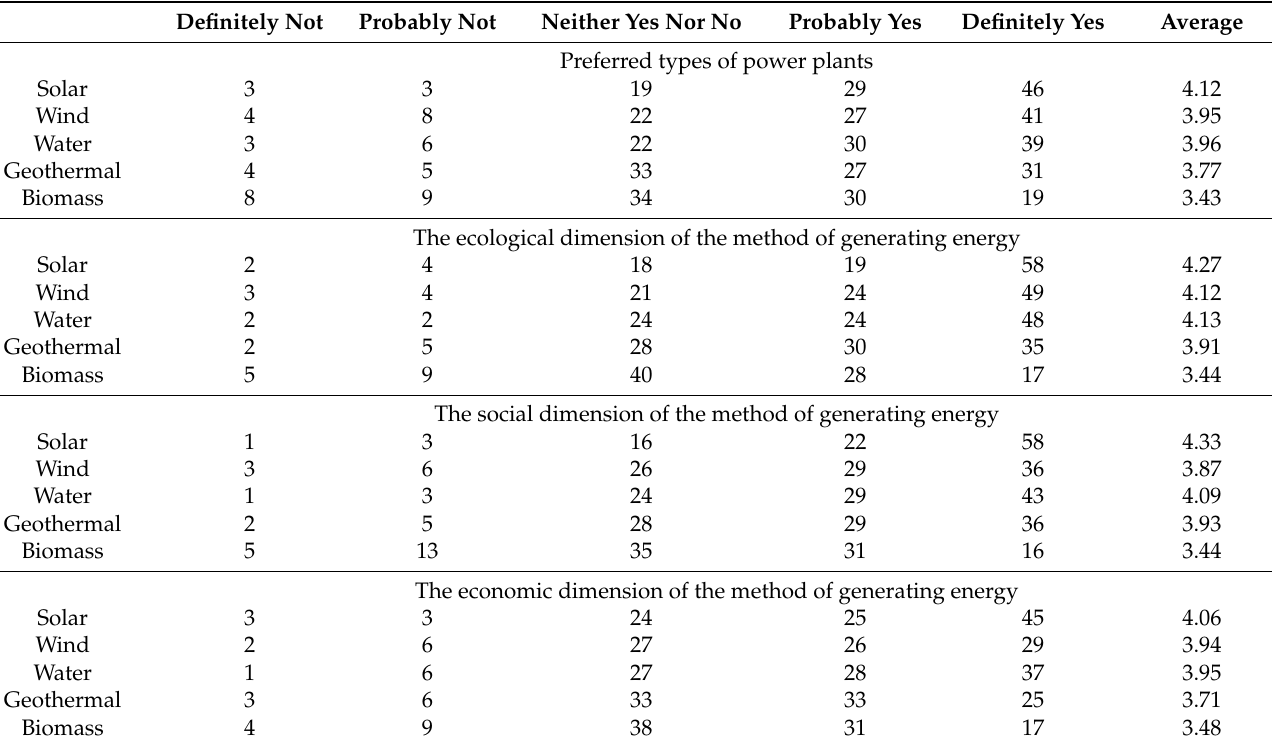
Table 1. Preferred types of power plants in the opinion of the Polish society